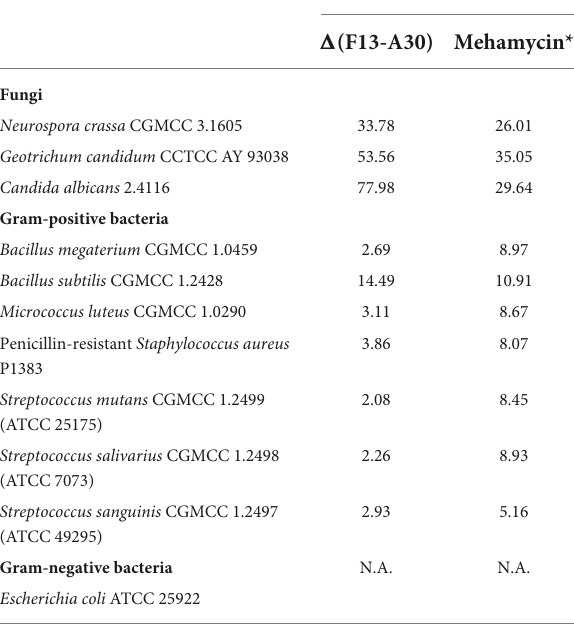
TABLE 2 Comparison of lethal concentrations (C L ) of (cid:49) (F13-A30) and mehamycin. Microorganism FIGURE6